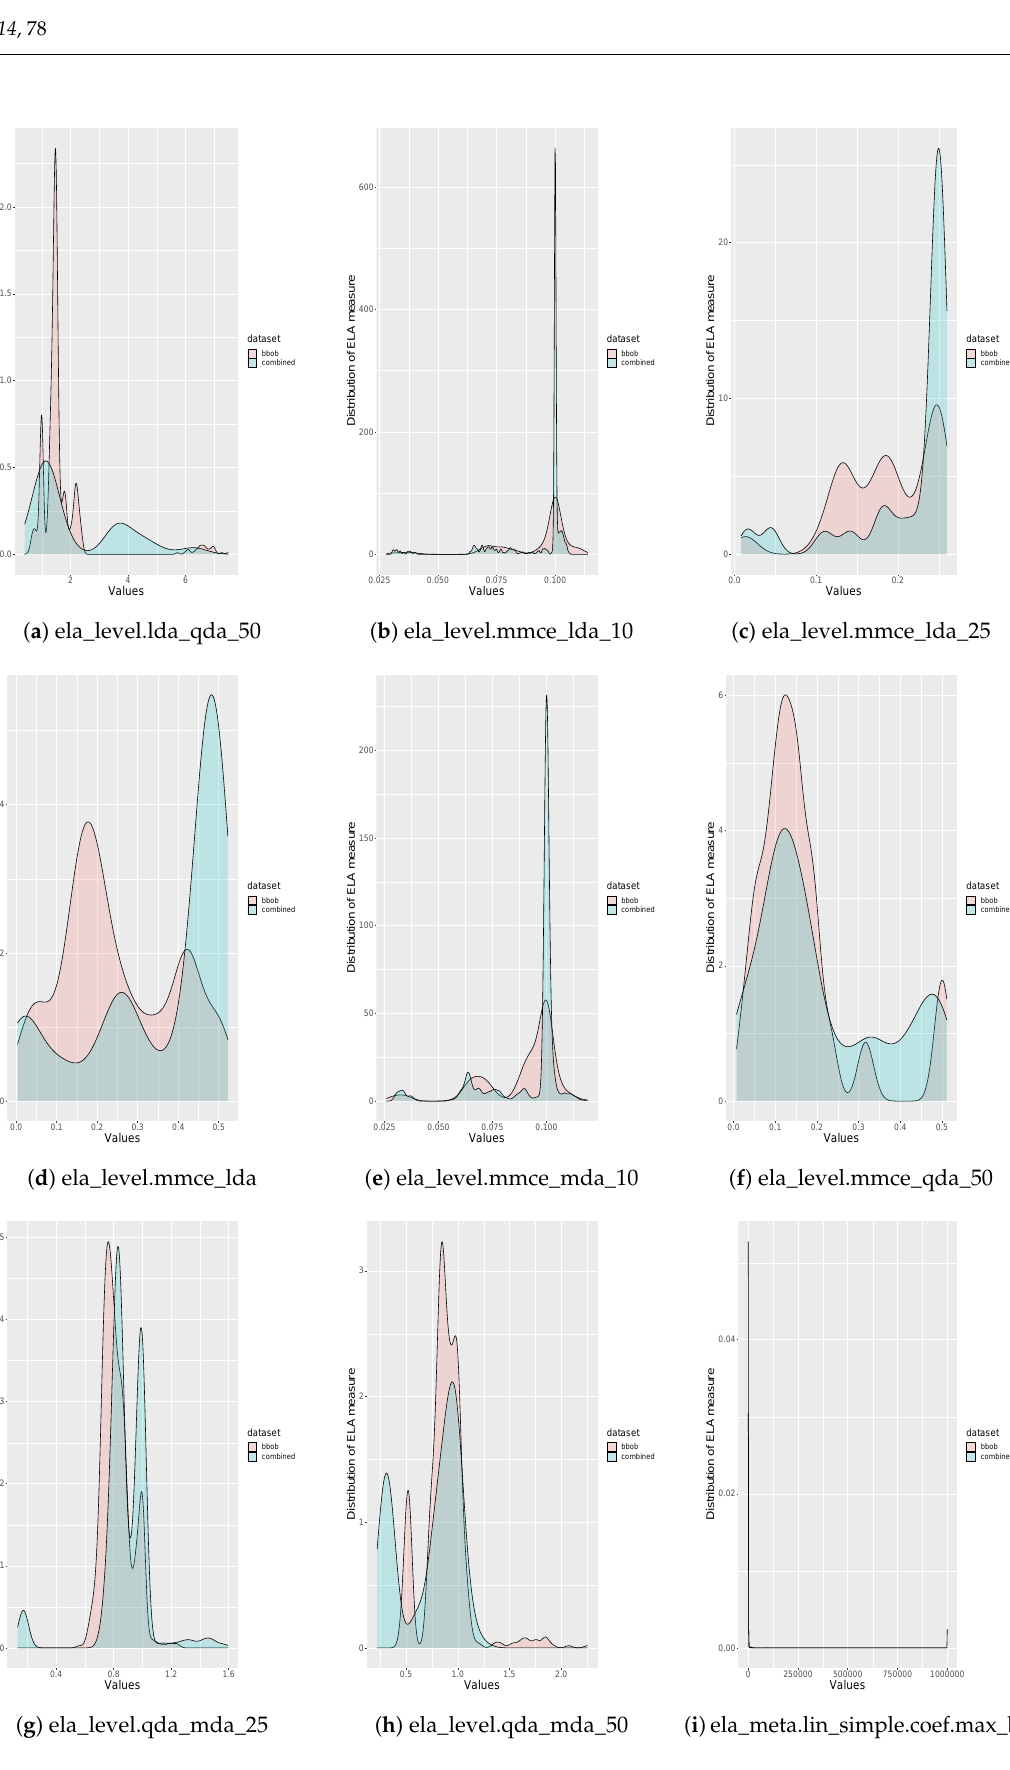
Figure 8. Comparison of the distributions of the BBOB benchmark suite and the proposed benchmark suite for all of the ELA measures used as input to the SOM